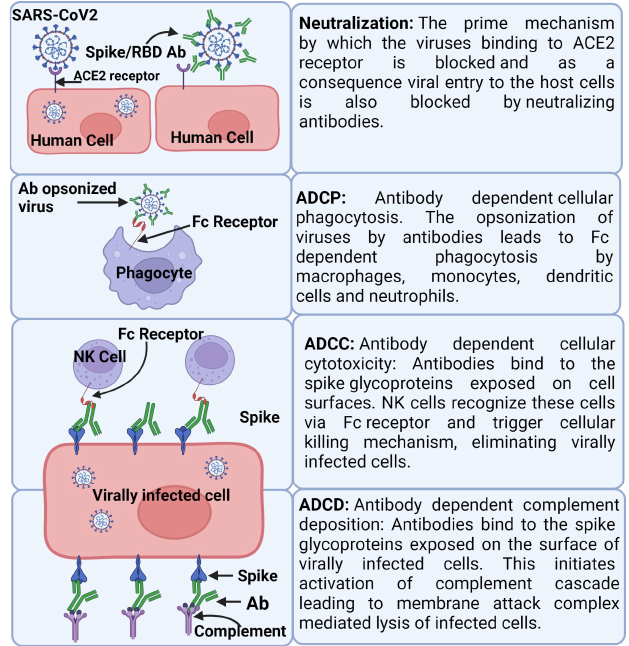
Figure 1. Antibody mediated protection against SARS-CoV-2: Created with BioRender.com (h tt ps://www.biorender.com/ accessed on 3 March 2023). 2.2. Cell-Mediated Immunity Although nAbs were initially considered to be most important in protection against COVID-19 [48,49], recent evidence suggests that virus-speci fi c T cells may synergize with nAbs for robust protection against SARS-CoV-2 [9]. The role of cell-mediated immunity (CMI) in controlling SARS-CoV-2 infection was recognized in the clinical trials with mon- oclonal Abs (mAbs), wherein mAb treatment clearly provided clinical bene fi t in the early stage COVID infection. Even though the likelihood of hospitalization was signi fi cantly reduced [50], the mAb treatment promoted only a modest reduction in viral load. On the contrary, individuals who are immunized/infected exhibited a substantial reduction in viral load [51]. This suggests that CMI may be critical in minimizing viral burden by con- trolling and eliminating infected cells [9]. Moreover, several clinical trials revealed that high-dose neutralizing mAb has no bene fi cial e ff ect in hospitalized individuals. However, the administration of mAbs before infection has been highly e ff ective in preventing severe disease following SARS-CoV2 infection in humans as well as non-human primates [9,52,53]. Thus, while early mAb treatment provides clinical bene fi t to high-risk individu- als at early stages of COVID/before infection, the actual impact of mAbs on viral loads is only modest, suggesting that Abs may not be the major e ff ector to viral clearance and that